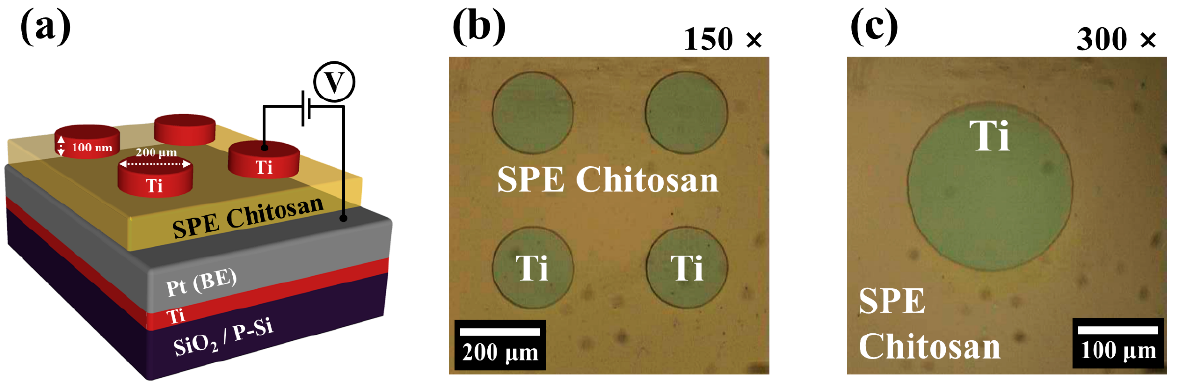
Figure 9. ( a ) Schematic diagram of the SPE-chitosan memristors (Ti/SPE-chitosan/Pt) and optical microscope images with magnifications of ( b ) 150 × and ( c ) 300 ×.